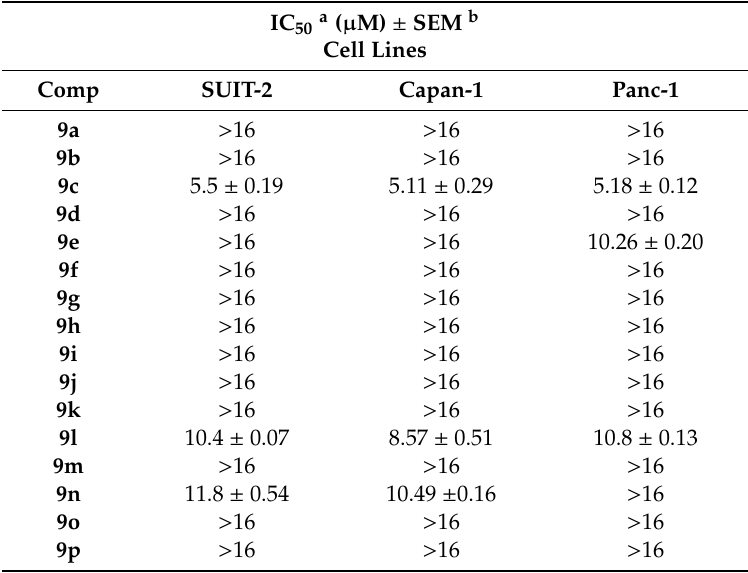
Table 2. IC 50s of SUIT-2, Capan-1 and Panc-1 cells treated with compounds 9a–p .